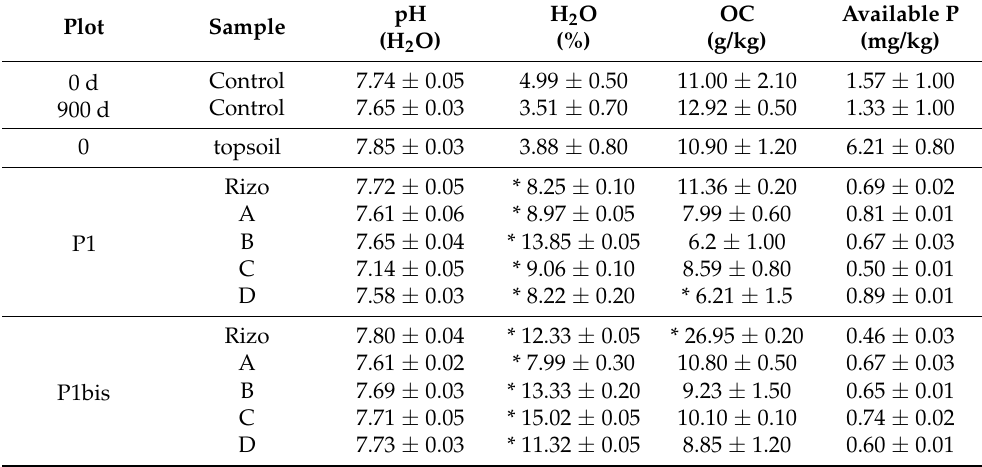
Table 2. Average values ( ± standard errors, s.e.) of pH, % H 2 O, organic carbon, available phosphorus in soil samples at 0 (t = 0 d) and 900 days after poplar-plantation in the various points of the P1 and P1bis planted plots and un-planted soil (control). Rizo: soil surrounding the root system, 0–30 cm depth; A: 0.25 m distance from the trunk and 0–20 cm depth; B: 0.25 m distance from the trunk and 20–40 cm depth; C: 1 m distance from the trunk and 0–20 cm depth; D: 1 m distance from the trunk and 20–40 cm depth. Statistical differences ( p < 0.05) resulted by ANOVA test are reported with a star symbol. pH H 2 O OC Available P Plot Sample (H 2 O) (%) (g/kg)